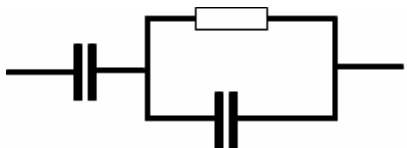
Figure 4. Schematic illustration of the electrical equivalent circuit (EEC). Resistor is represented by the symbol and capacitor represented by . Table 1. The parameters of the circuit elements of the poly (vinyl alcohol) (PVA):LiFC 3 SO 3 solid electrolyte at various temperatures.